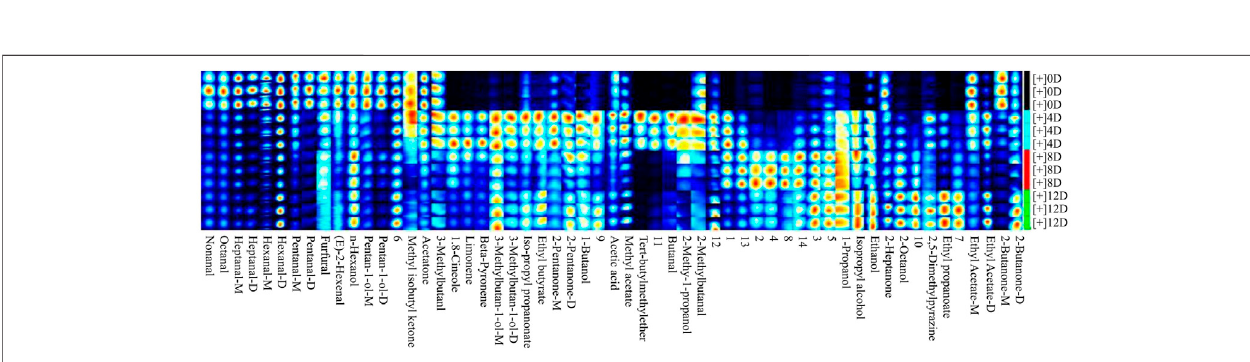
Frontiers in Bioengineering and Biotechnology |